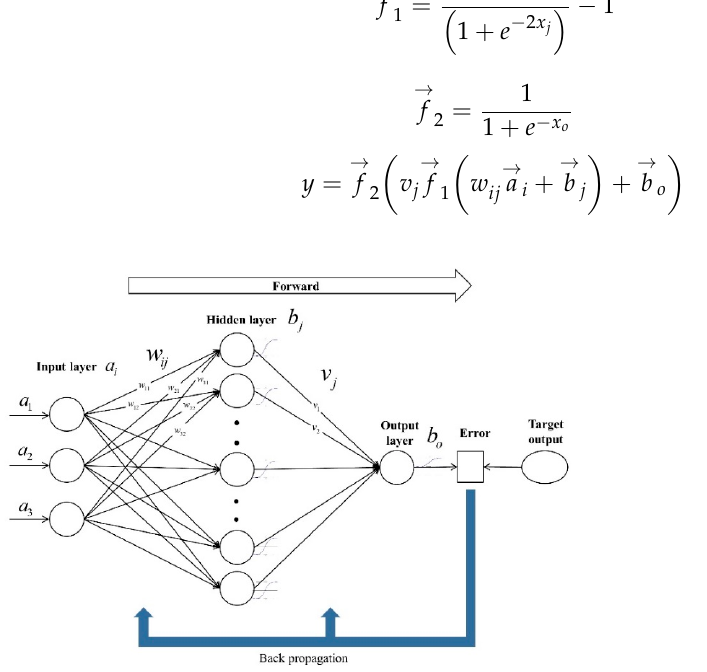
Figure 13. Simple ANN model.